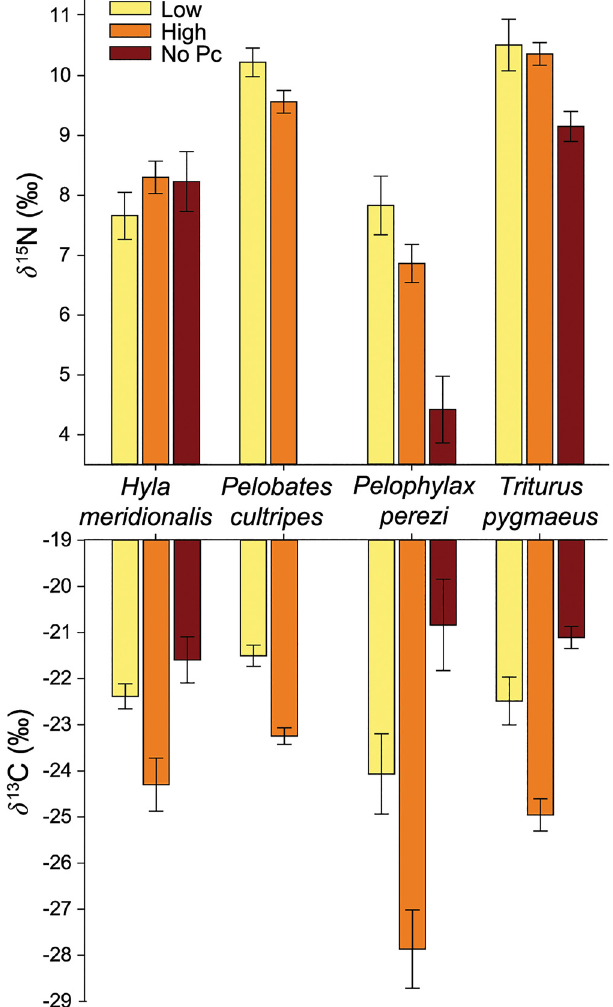
Fig 2. Stable isotopic values for each amphibian species in the density treatments of the experiment. δ 15 N and δ 13 C values (mean ‰ ± SE) of H . meridionalis , P . cultripes , P . perezi , and T . pygmaeus muscle in three different density treatments: low density of amphibian larvae ( Low ), a three-fold increase of the density from the low treatment ( High ), and exclusion of the competitive species P . cultripes ( No Pc ).